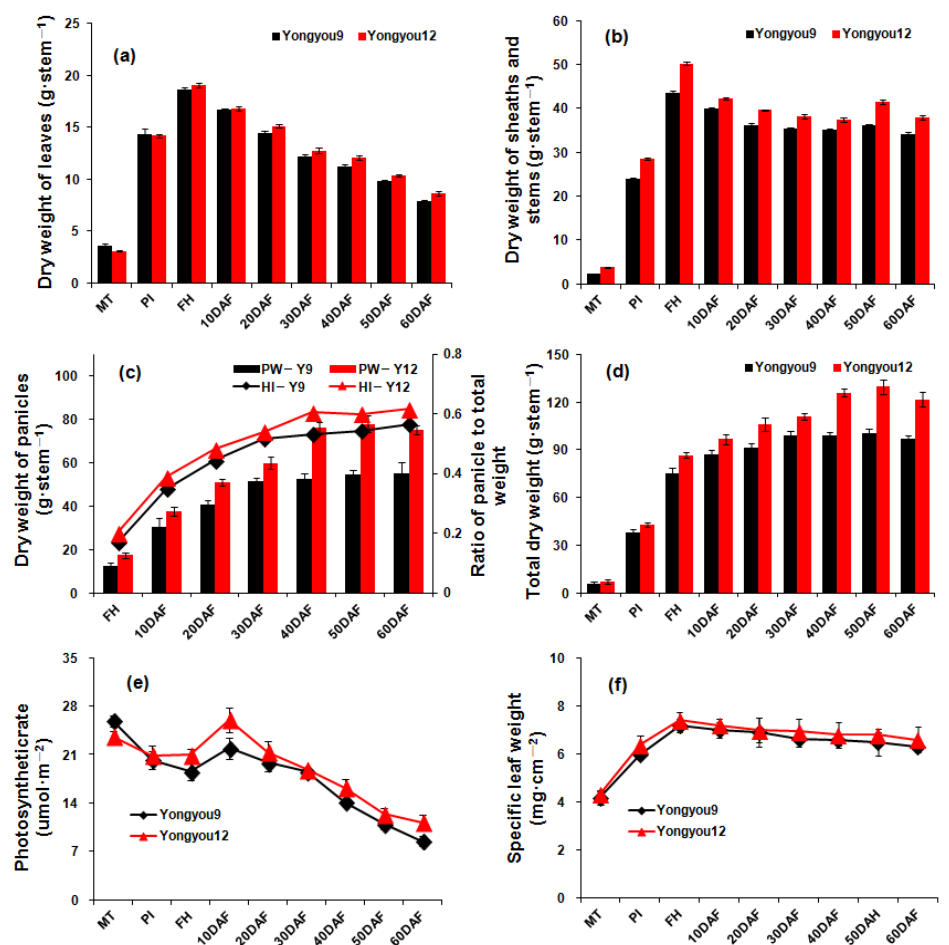
Figure 5. Photosynthetic assimilate production characteristics of rice: ( a ) leaf dry weight; ( b ) sheath and stem dry weight; ( c ) panicle dry weight; ( d ) total dry weight; ( e ) net photosynthetic rate; ( f ) specific leaf weight. MT, PI, and FH denote mid-tillering, panicle initiation, and full-heading stage, respectively; DAF denotes days after flowering; Y9 and Y12 indicate rice varieties, Yongyou9 and Yongyou12, respectively; HI indicates the ratio of panicle weight to total weight (harvest index). Error bars denote ± standard deviation ( n = 3). Table 1. Parameters of grain filling fitted by Richards’